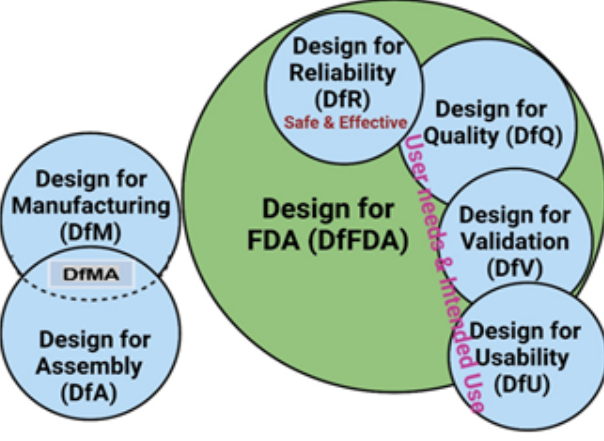
Figure 6. DfX for the MedTech sector [6].